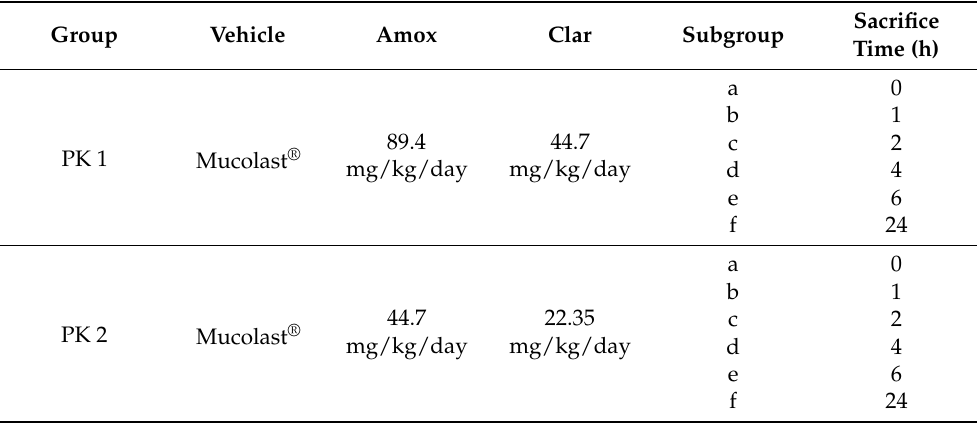
Table 1. Pharmacokinetic (PK) groups per formulation, time, and dose. Amox: amoxicillin; Clar: